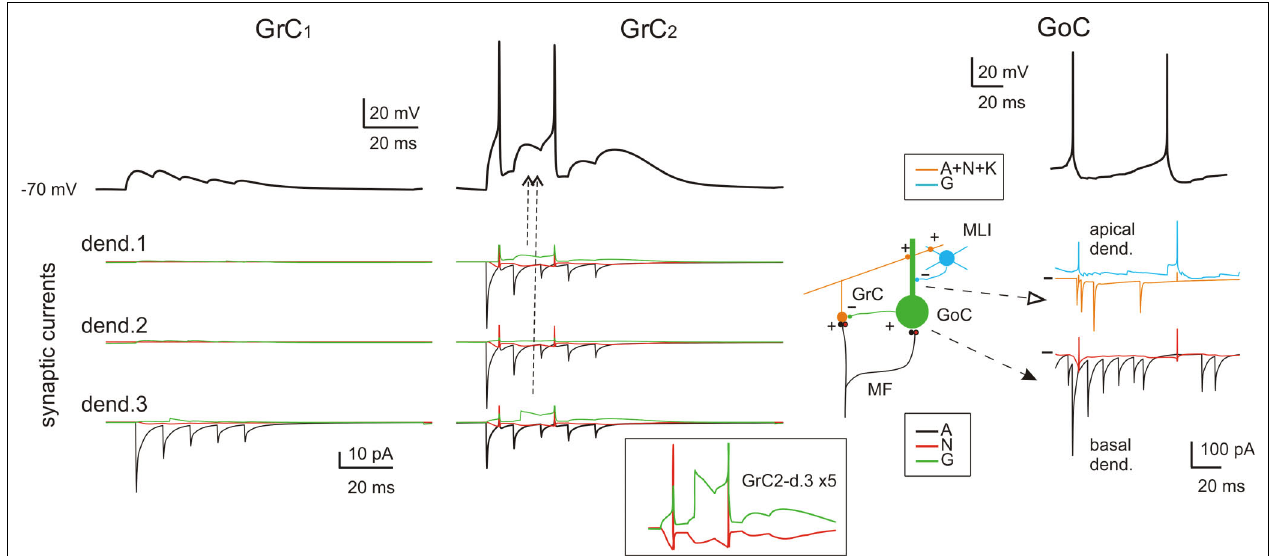
FIGURE 3 | Subcellular mechanisms of GrC and GoC responses. Response of the NMDA and GABA-A currents build-up up on enlarged scale (vertical axis × 5). two exemplar GrCs and one GoC activated by a mf burst (fi ve spikes at 500 Hz on In GoCs, several pf and mf synapses contribute to generate the glutamatergic eight contiguous mfs). The top traces show intracellular membrane potential inputs on apical and basal dendrites, respectively. The pf input involves activation while the bottom traces show the synaptic membrane currents. All glutamate of AMPA, NMDA and kainate receptors, while the mf input activates AMPA and receptor-dependent currents (A = AMPA, N = NMDA, K = kainate) are downward NMDA receptors. The inhibitory input from molecular layer interneurons (MLI) while the GABA-A receptor-mediated currents (G = GABA-A: α 1 and α 6 receptor- occurs on the apical dendrites. Note generation of a spike doublet by the EPSCs mediated currents together) are upward, except when changes in the driving occurring through the feed-forward (fi lled arrow) and feed-back (open arrow) force invert the current sign (glutamate reversal potential = 0 mV and GABA loops. The pf EPSCs occur with some delay compared to mf EPSCs, accounting reversal potential = − 65 mV). GrC for the time required for GrC excitation and pf-GrC transmission, and are receives only 1 mf input, GrC receives 3 mf 1 2 interrupted by GoC inhibition of GrCs. MLIs intensify their action just after inputs and 2 GoC inputs. Note inhibition of spike generation by evoked IPSCs in GrC (arrow). In contrast to AMPA current short-term depression, the inset shows 2